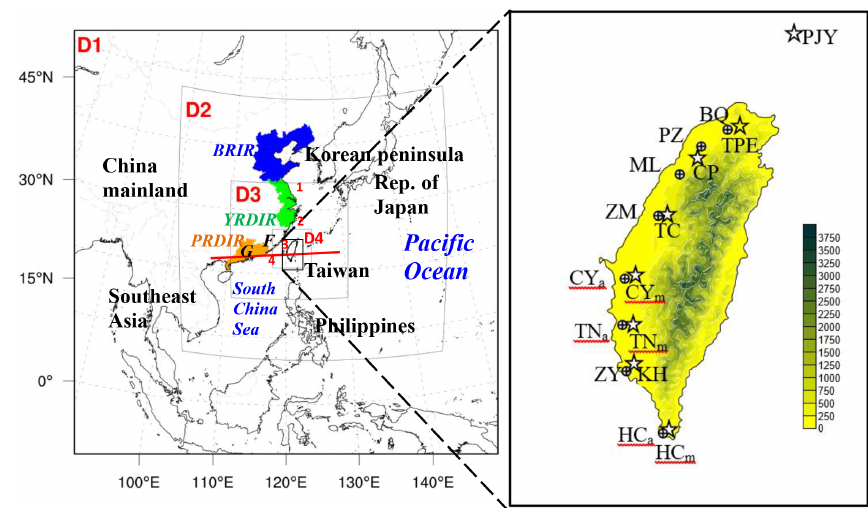
Figure 1. Geographic location of three major industrial regions (BRIR – enclosed region with the blue line; YRDIR – green; PRDIR – orange) in East Asia and meteorological and air quality stations in Taiwan. The meteorological stations include Peng Jiayu (PJY), Taipei (TPE), Chupei (CP), Taichung (TC), Chiayi (CY m ), Tainan (TN m ), Kaohsiung (KH), and Hengchun (HC m ). The air quality stations include Banqiao (BQ), Pingzhen (PZ), Miaoli (ML), Zhongming (ZM), CY a , TN a , Zuoying (ZY), and HC a . The numbers from 1 to 4 in red along the coast of eastern China represent the locations of the Bohai Sea, East China Sea, Taiwan Strait, and northern South China Sea, respectively. The red line is the cross-section plot of Fig. 4. F and G indicate the locations of Fujian and Guangdong provinces, respectively.